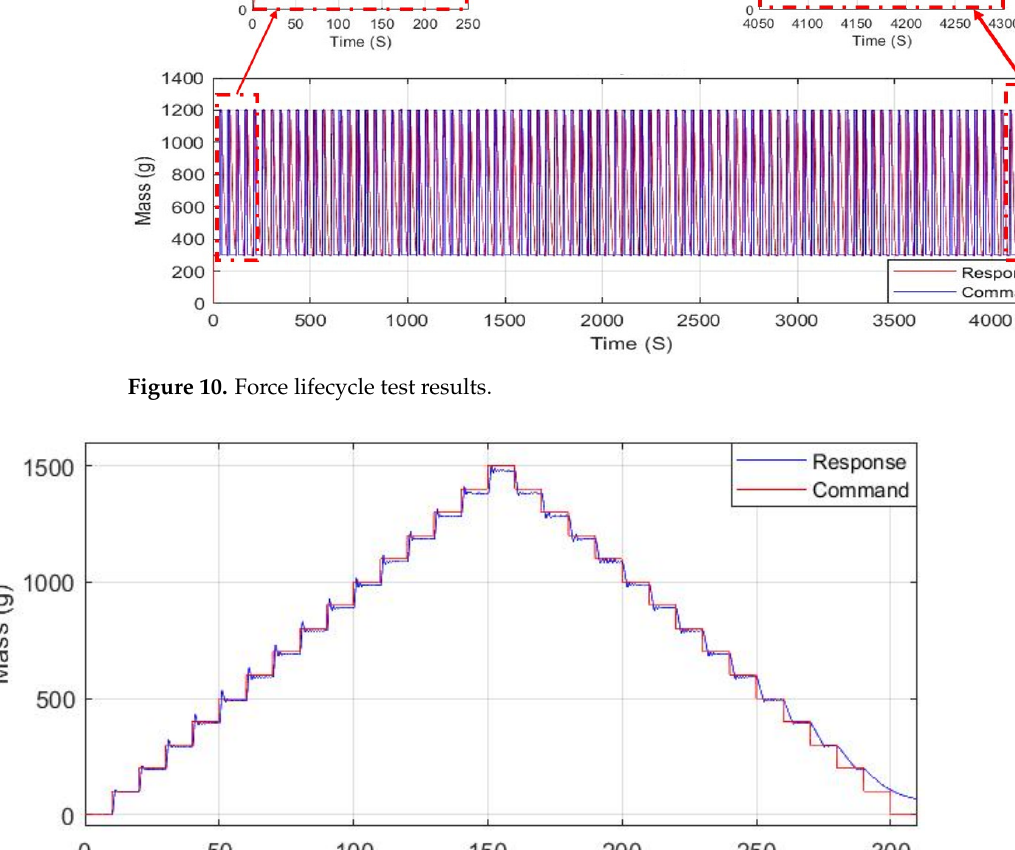
Figure 12. Closed-loop force control of a sine command signal. The test performed to measure the maximum tensile force for the NiTiNOL springs showed that one spring can carry up to 1.5 Kg, which amply a force ( F ) of 14.7N accord- ing to Equation (1). 𝐹 = 𝑚 × 𝑔